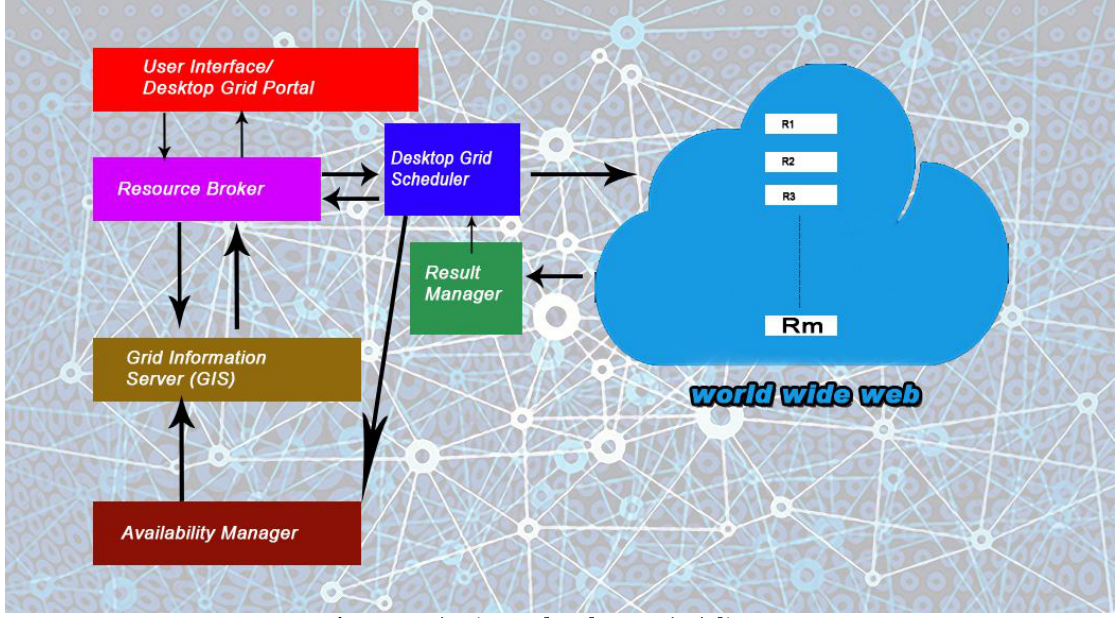
Figure 1. Adaptive Fault Tolerant Scheduling